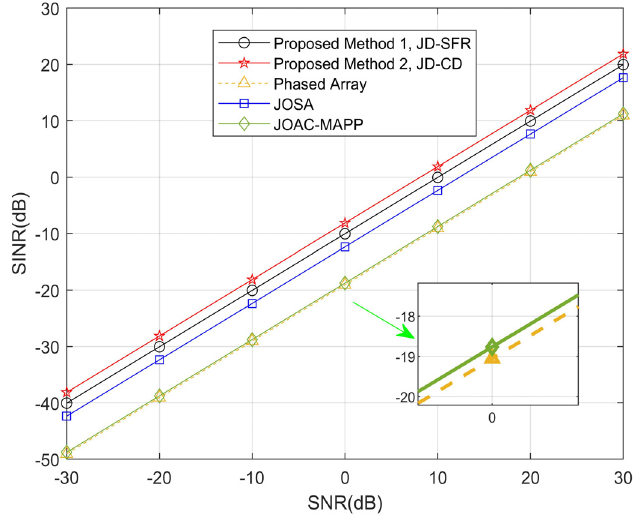
Figure 8. Comparison of obtained SINR using the proposed method and other methods for ◦ ∆ θ min = 10